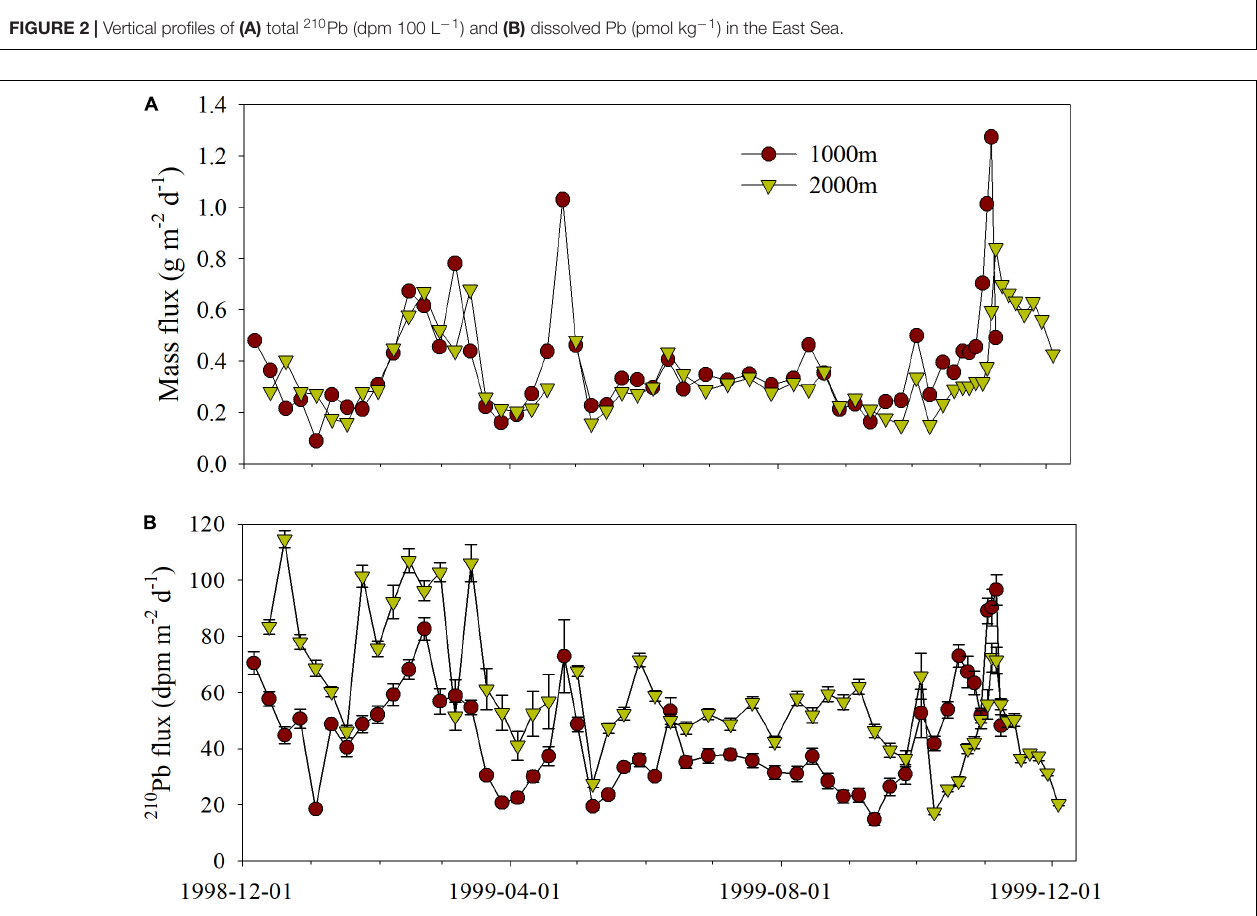
FIGURE 3 | One-year time series data (December 1998 to December 1999) of (A) total particulate flux (g m − 2 d − 1 ) and (B) 210 Pb (dpm m − 2 d − 1 ) flux in the sinking particles.